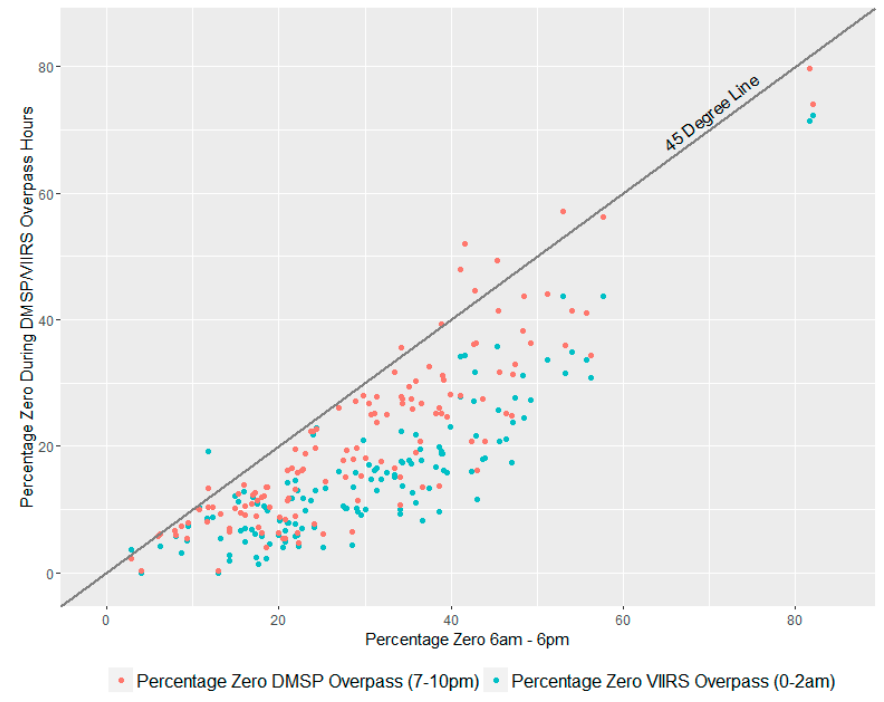
Figure 3. Relationship between daytime and nighttime zero voltage frequency on feeder lines for 137 Divisions in Maharashtra, 2007–2013. Observations of day and nighttime outage rates presented for the DMSP overpass time ( red ), and the VIIRS sensor overpass time ( blue ), with a 45-degree line ( black line ).